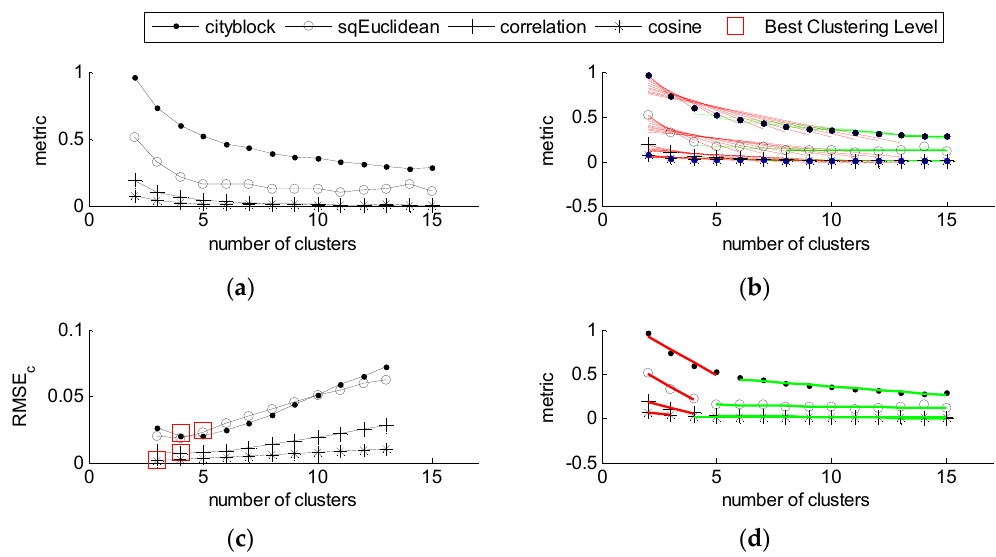
Figure 5. ( a ) evaluation graph, ( b ) possible fitting lines, ( c ) RMSE, and ( d ) Best-fit lines for city-block distance, Euclidean distance, correlation distance, and Cosine similarity.